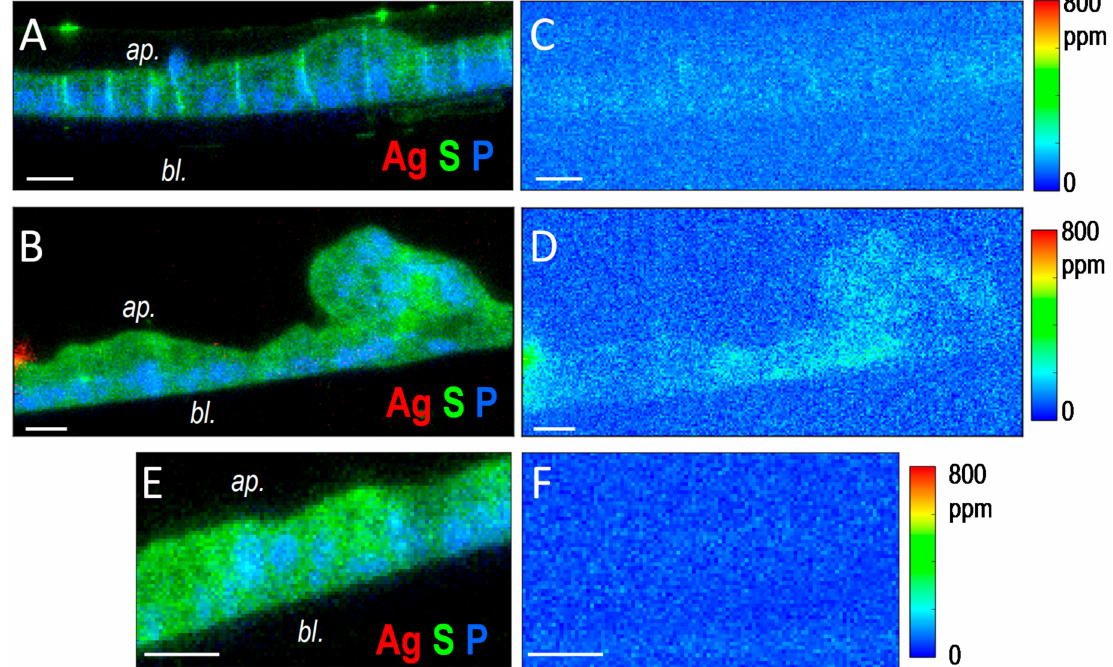
Figure 6. XRF: silver (red), sulfur (green) and phosphorous (blue) distribution in gastrointestinal epithelia exposed to: ( A ) dig or ( B ) undig AgNPs, and ( E ) in untreated cells. The apical (ap.) and basolateral (bl.) sides of the epithelia are indicated over the images. False-color representation of Ag concentration in the same areas of gastrointestinal (GI) epithelia exposed to: ( C ) dig AgNPs or ( D ) undig AgNPs, and ( F ) in untreated cells. Elemental distributions and concentrations were extracted from µ XRF hyperspectral images. Scale bars = 20 µ